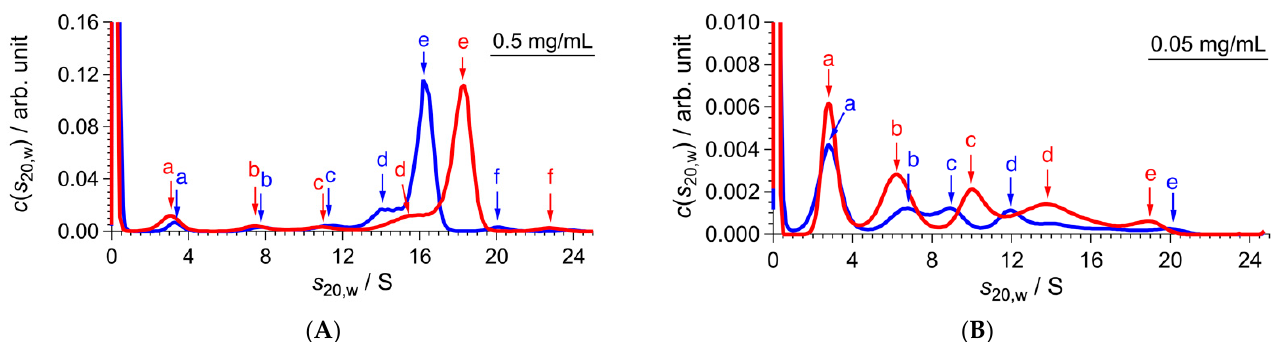
Figure 4. SV-AUC results of CgHspB1 WT with and without DTT at 40 °C. Blue and red lines represent c ( s 20,w ) with and without DTT, respectively. ( A , B ) show the results at 0.5 mg/mL and 0.05 mg/mL, respectively. Colored arrows and letters (a, b, c, d, e, f) corresponding to the data with the same colors show the peak positions whose parameters are listed in Table 3.